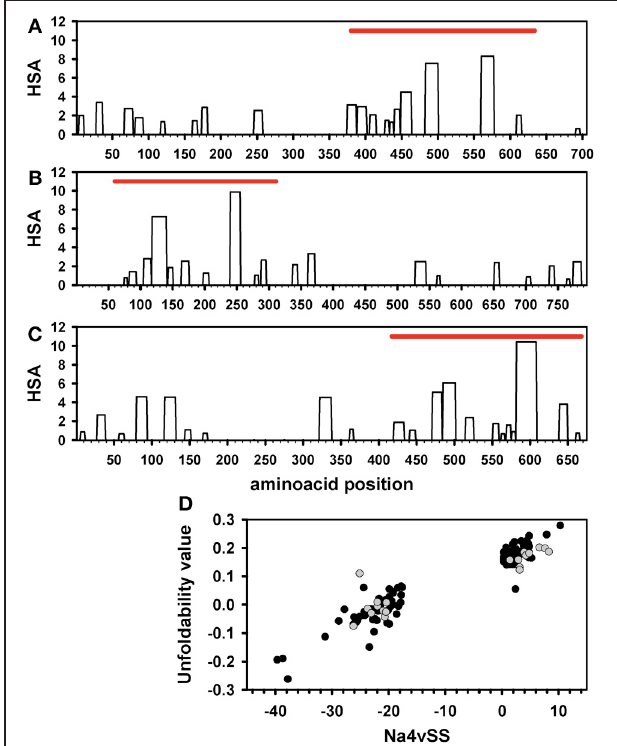
FIGURE 6 | Aggregation prone-regions and intrinsic disorder in kinases. AGGRESCAN Hot-Spot Area (HSA) profile for individual kinase proteins: (A) PKCt (AGC), (B) MARK1 (CAMK), and (C) BMX (TK). The position of the corresponding kinase domain is represented by a red bar. (D) Intrinsical unfolding propensity of the 10% kinase proteins with the lowest and highest Na4vSS values in the human (black) and yeast (gray) datasets. Intrinsical unfolding propensity predictions were performed using the FoldIndex